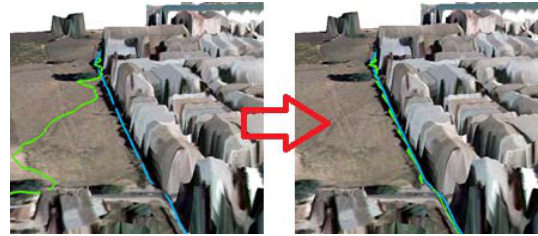
Figure 12. Cartographic burning-in